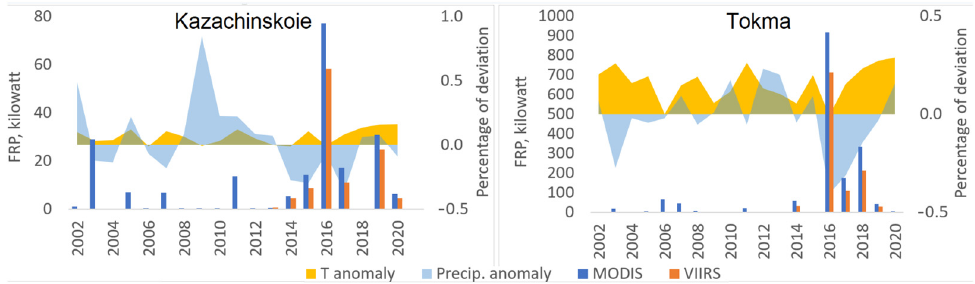
Figure 3. Dynamics of annual cumulative Fire Radiative Power (FRP) changes, and temperature and precipitation anomalies at weather stations in the study areas.